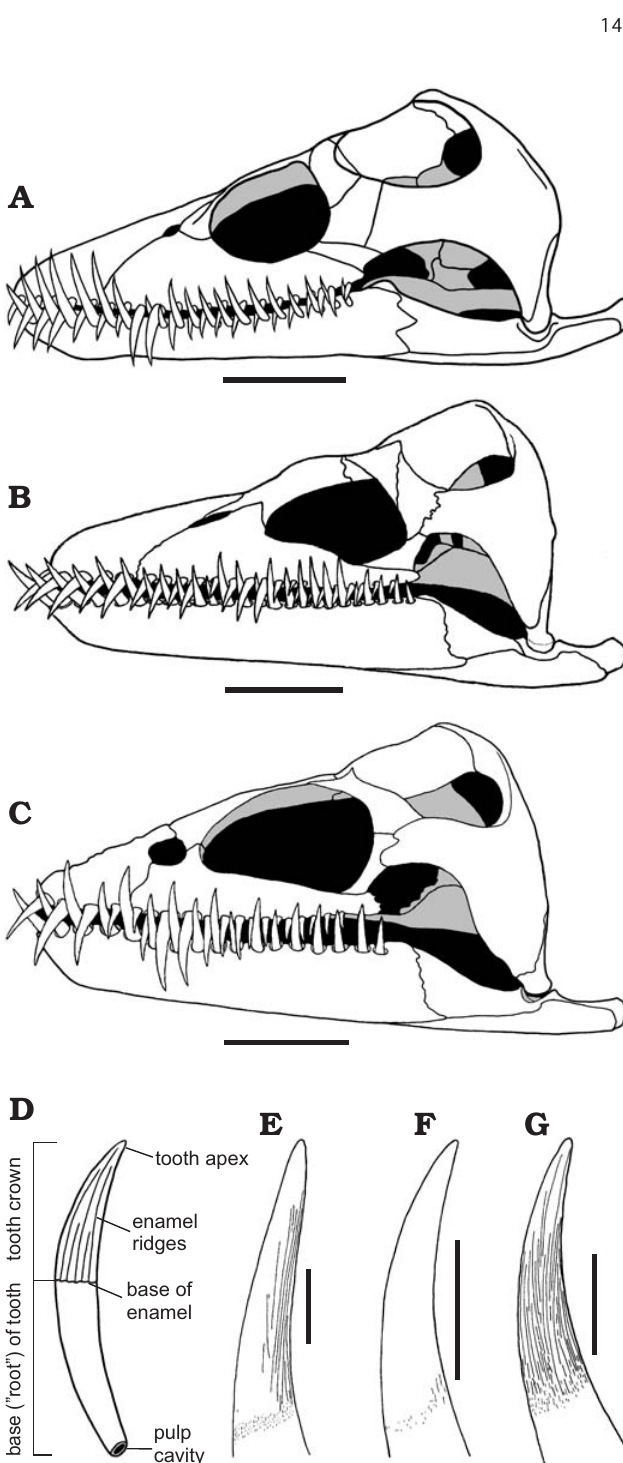
Fig. 5. Reconstructions of skulls (A–C, in left lateral view) and teeth (D– G, in axial view, with lingual surface to the right) of plesiosaurs from the Oxford Clay Formation, Callovian and Oxfordian. A , E . Muraenosaurus leedsi . B , F . Cryptoclidus oxoniensis . C , G . Tricleidus seeleyi . D . Gene- ralized plesiosaur tooth showing overall morphology. Images from: A, Evans (1999); B, Brown and Cruickshank (1994: fig. 5); C, Brown (1981b: fig. 22); D, LFN drawings; E, Brown (1981b: fig. 19a, modified); F, Brown (1981b: fig. 5) with additional information from Andrews (1910); G, Brown (1981b: fig. 24a). Scale bars A–C, 50 mm, E–G, 10 mm, D not to